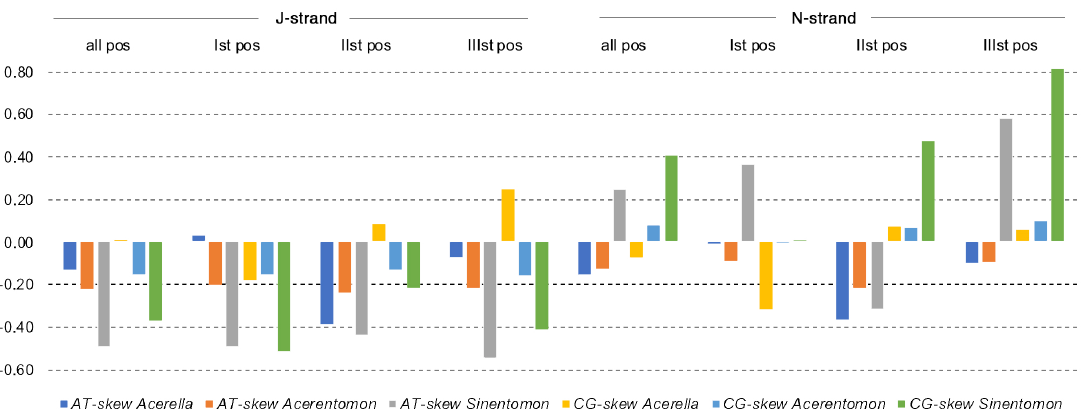
Figure 3. AT- and CG-skew values observed in genes encoded on the J and N strand. Figures are given for concatenated PCGs and separately for each of the three codon